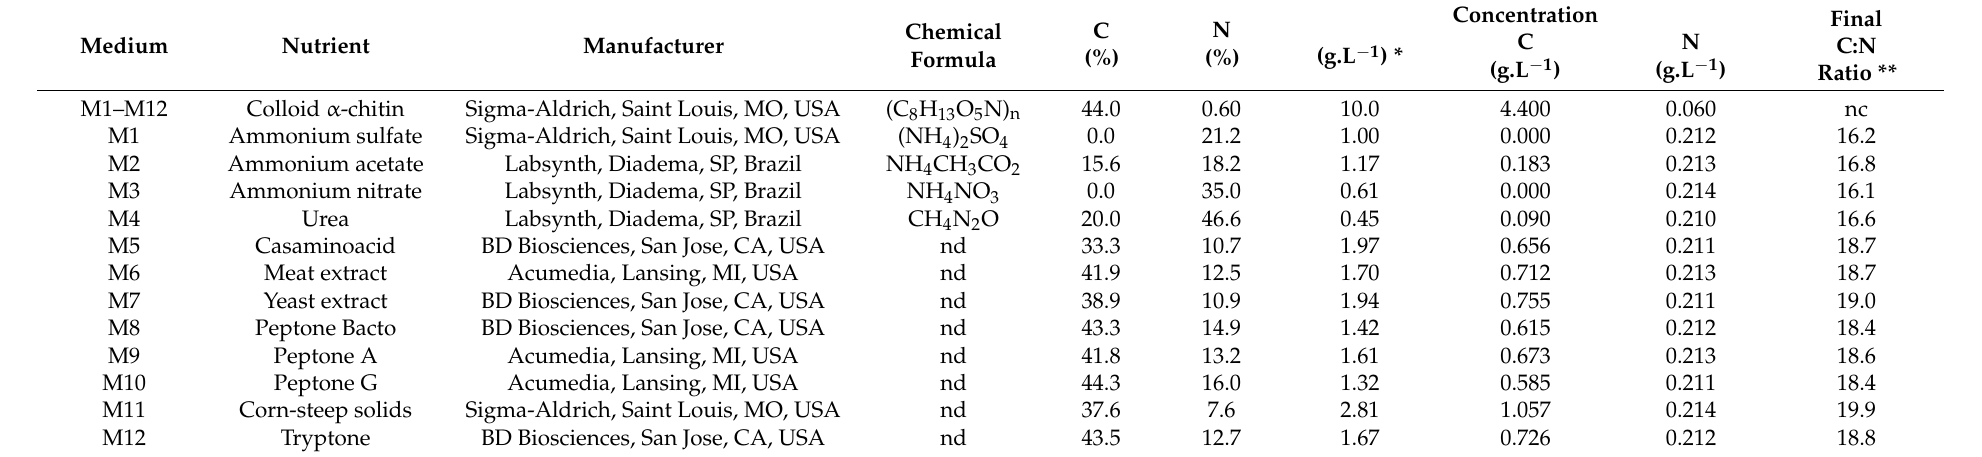
Table 1. Characteristics of nutrients used for Aeromonas caviae CHZ306 growth and chitinase